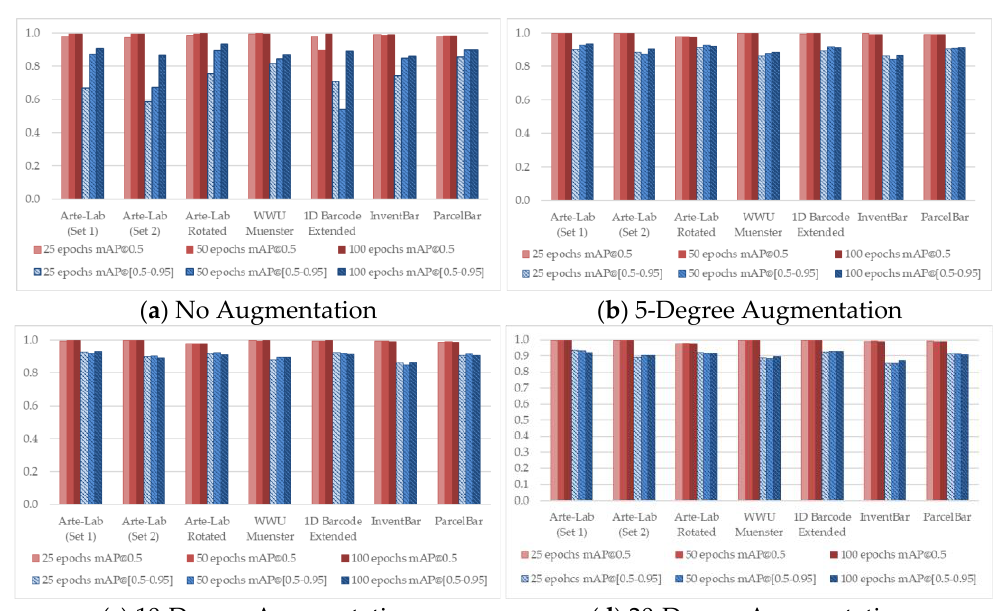
Figure 7. Recognition rate of YOLO v5 applied over seven public barcode datasets.